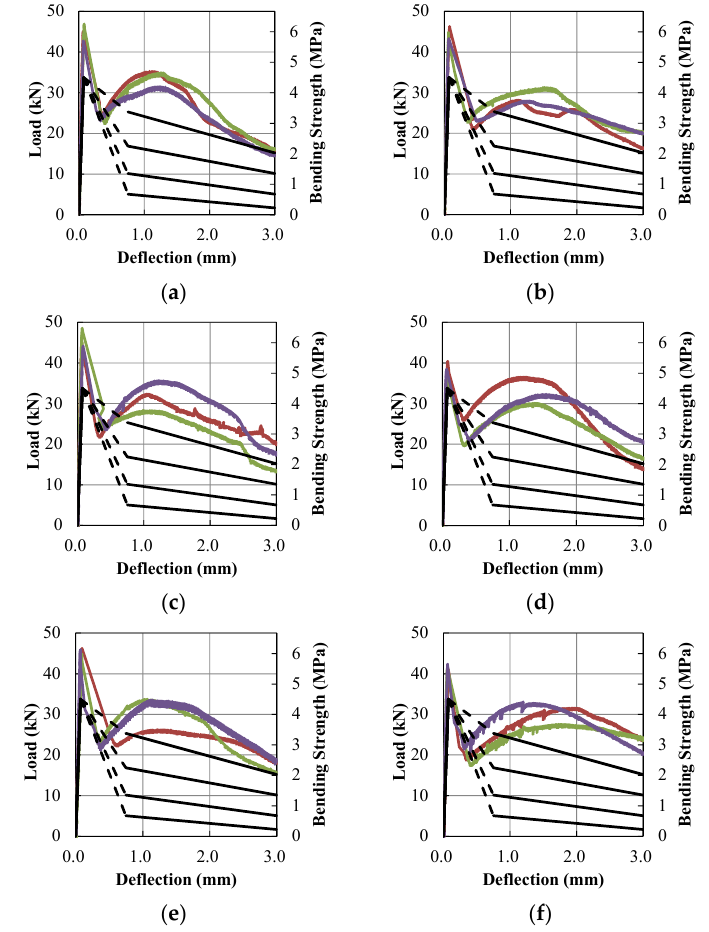
Figure 8. ( a ) PA ‐ 0.6L; ( b ) PA ‐ 0.6F; ( c ) PA ‐ 0.7L; ( d ) PA ‐ 0.7F; ( e ) PA ‐ 0.8L; ( f ) PA ‐ 0.8F. Figure 8. ( a ) PA-0.6L; ( b ) PA-0.6F; ( c ) PA-0.7L; ( d ) PA-0.7F; ( e ) PA-0.8L; ( f )